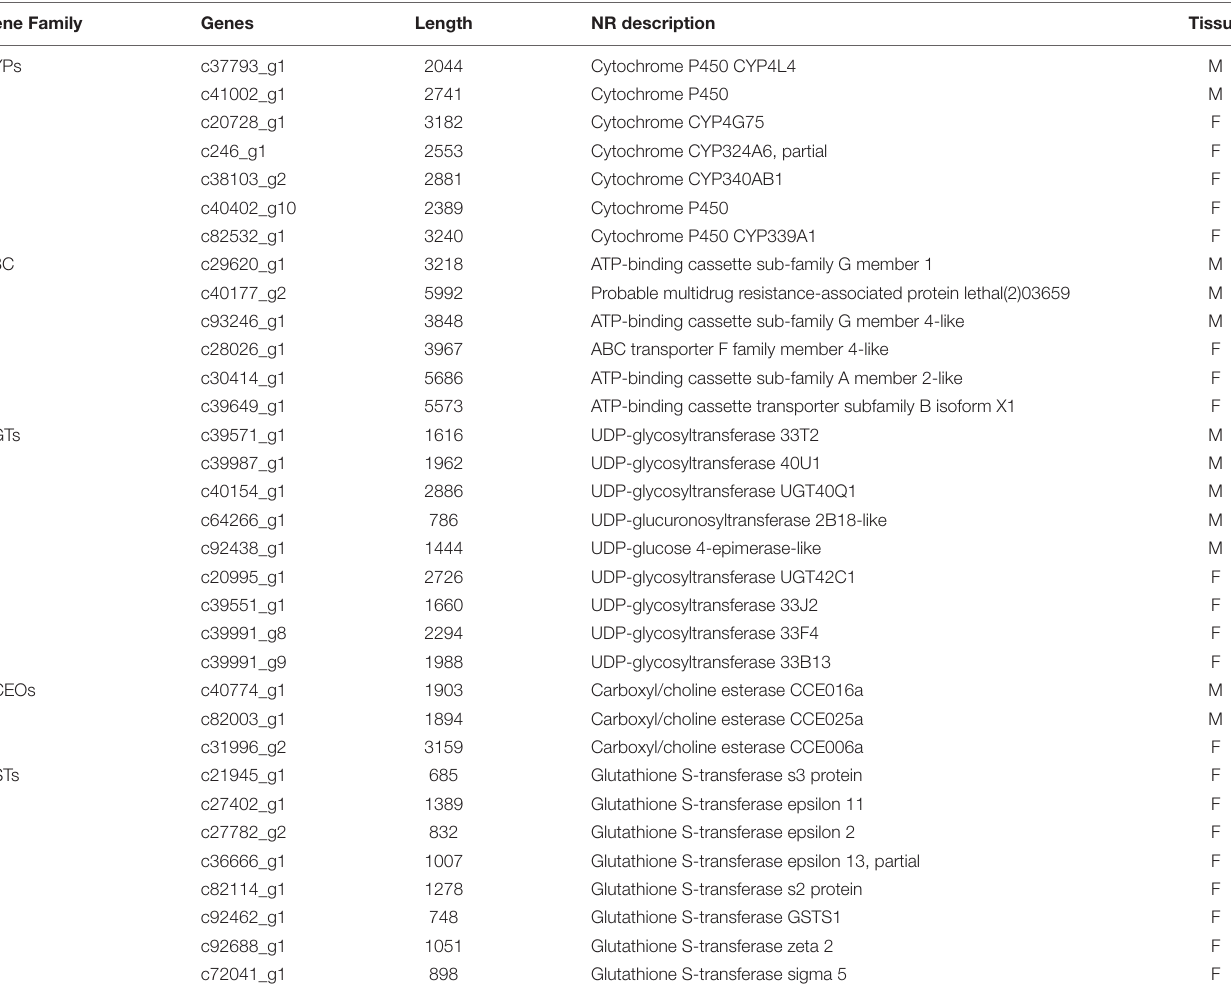
TABLE 1 | Up-regulated differentially expressed genes in Midgut and Fat